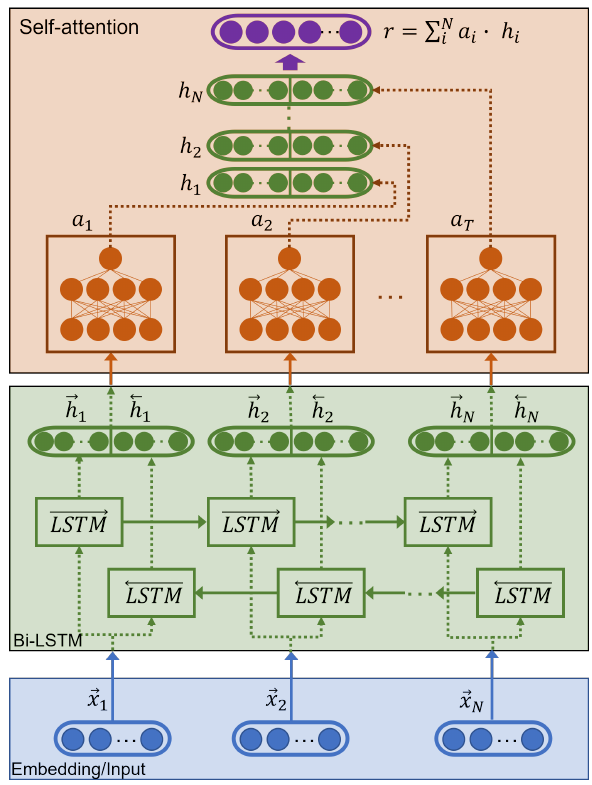
Figure 4. Bidirectional-LSTM with attention mechanism for facial emotion recognition at the video level. Modified version from source